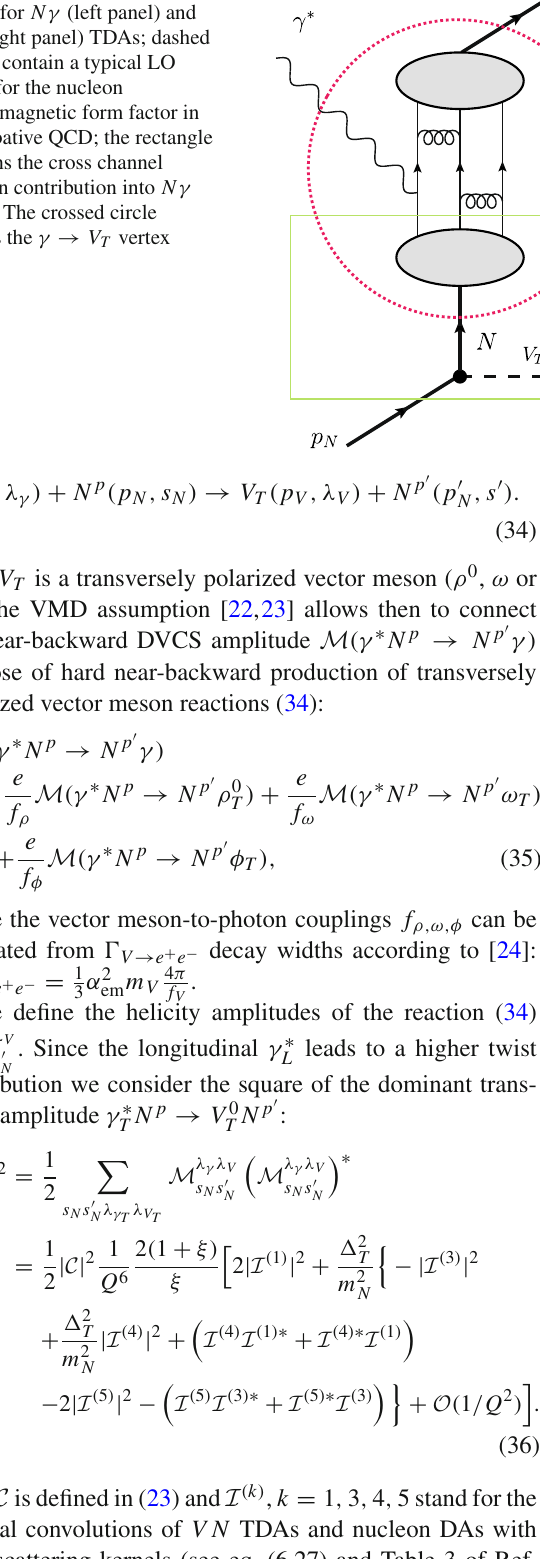
Fig. 7 VMD-based cross channel nucleon exchange model for N γ (left panel) and γ N (right panel) TDAs; dashed circles contain a typical LO graph for the nucleon electromagnetic form factor in perturbative QCD; the rectangle contains the cross channel nucleon contribution into N γ TDAs. The crossed circle depicts the γ → V T